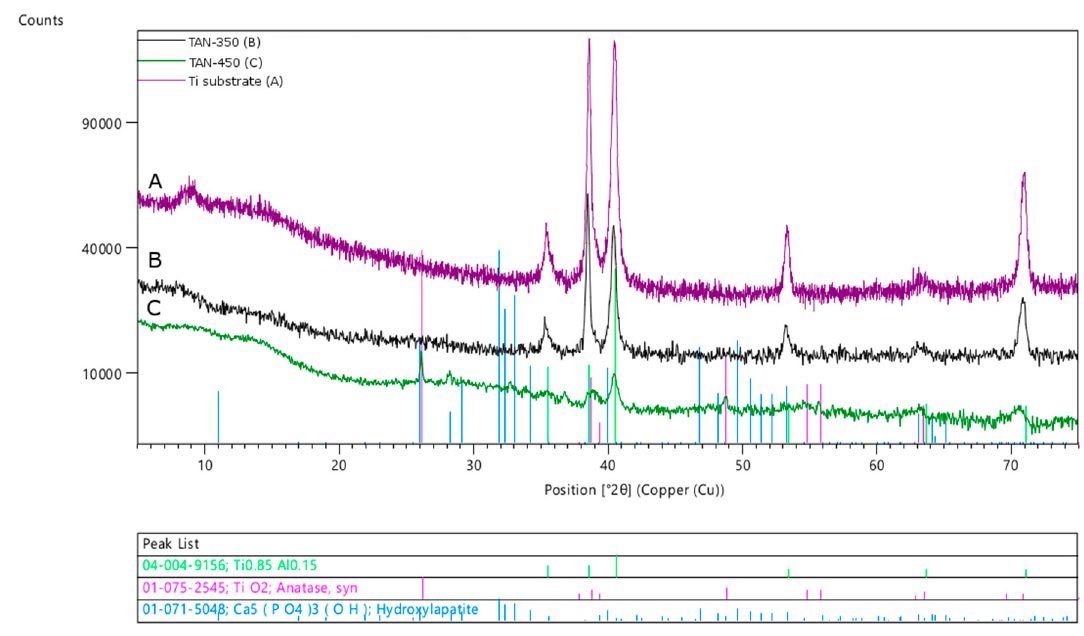
Figure 8. XRD pattern of: ( A ) TAN-350, ( B ) TAN-450 and ( C ) Ti